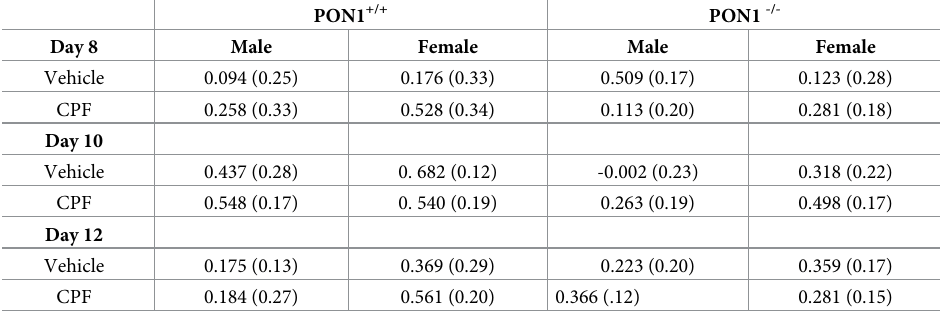
Table 1. Nest odor preference index compared to odor from a strange cage; [(Home odor—Stranger odor) / (Home odor + stranger odor)]. Data presented are Mean (SEM). The number of pups per group is the same as in the legend for Fig 4. PON1 +/+ PON1 -/-